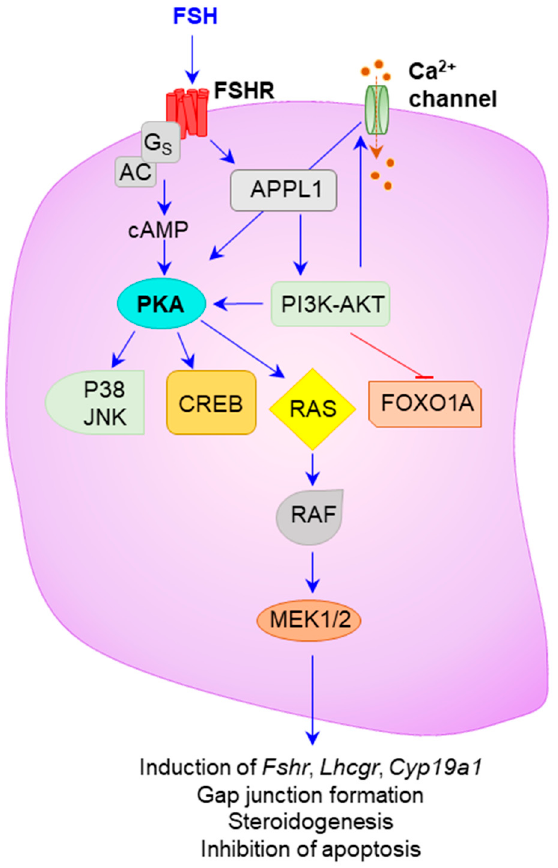
Figure 3. FSH signaling in the ovarian follicles. FSH signaling is necessary for the development of follicles during preantral to antral transition. Binding of FSH to FSHR can activate GCs in both a cAMP-dependent and independent manner. Upon FSH binding, FSHR recruits G s and AC, leading to activation of the cyclic AMP/protein kinase A (cAMP/PKA) pathway. Alternatively, PI3K/AKT can be activated upon FSHR interaction with APPL1. Through phosphorylation, PI3K/AKT directly inhibits FOXO1A, which leads to upregulation of FOXO-regulated genes involved in cell proliferation. In addition, PI3K/AKT activation of Ca 2+ channel leads to an increase in intracellular calcium concentration, which is crucial for follicle selection and dominance. PI3K/AKT can also activate the RAS/RAF/MEK singling that plays an important role in the induction of Fshr , Lhcgr , Cyp19a1 expression, gap junction formation, steroidogenesis, and inhibition of apoptosis.